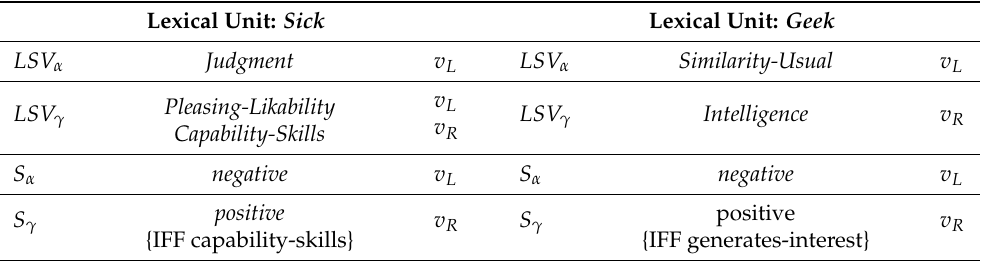
Table 4. Tagging lexical units with borderline cases. Lexical Unit: Sick Lexical Unit: Geek